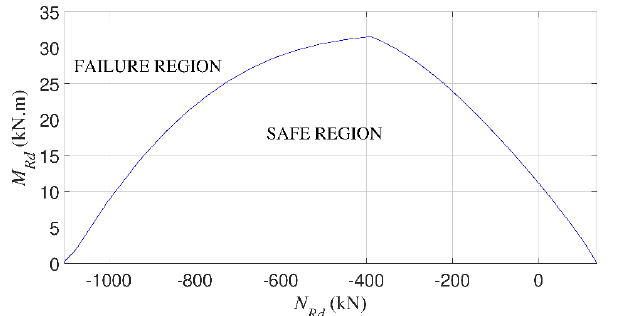
Figure 3. Load-moment interaction